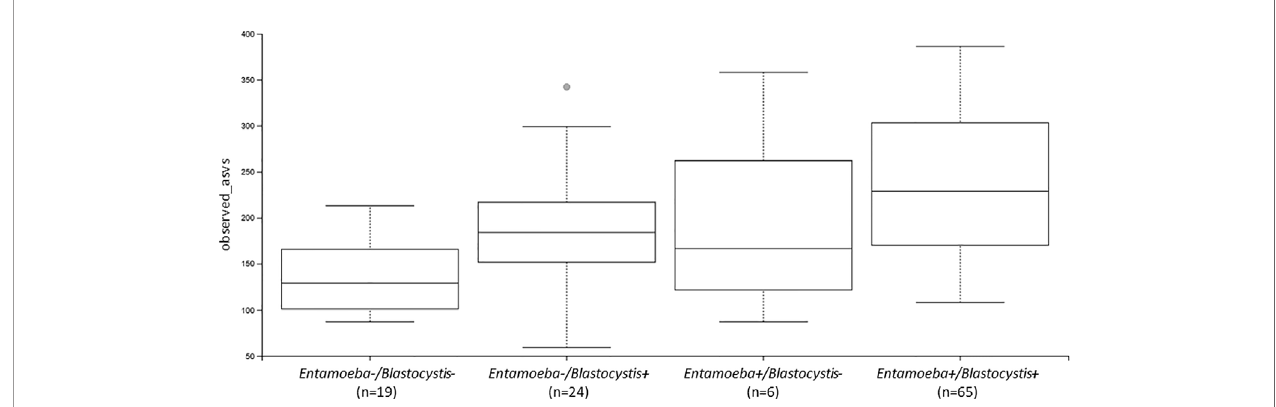
FIGURE 5 | Boxplots showing the differences in the number of observed ASVs between individuals colonized by no protozoan, only Blastocystis , only Entamoeba or both protozoa (Ent, Entamoeba ; Blasto, Blastocystis ).